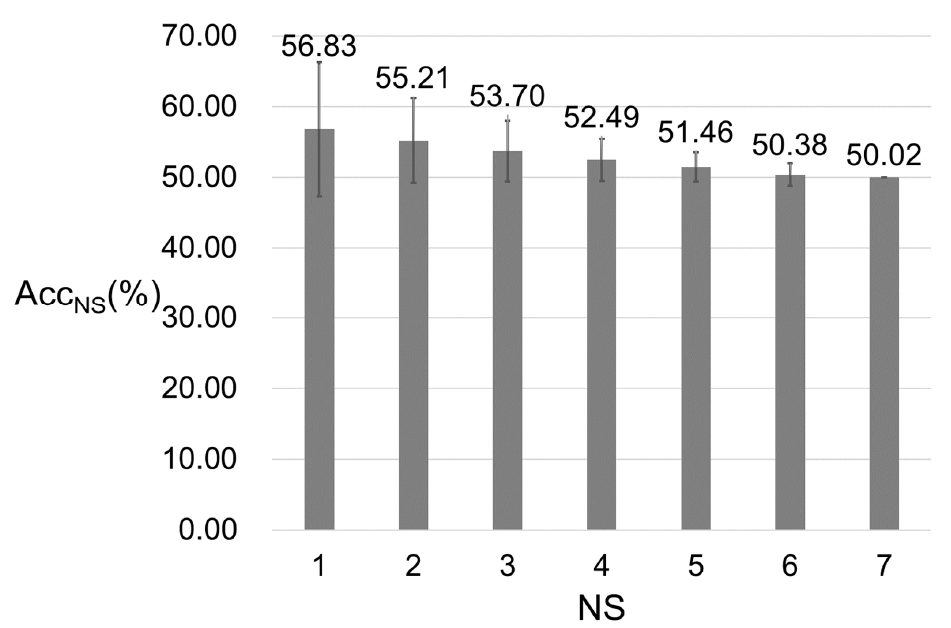
Figure 10. Relation between Acc NS-mean and NS. NS is the number of subjects. For each NS, we listed all possible subject combinations of NC subjects and constructed a new dataset for each combination by combining datasets of subjects in the combination. For each combination, after performing the random forest algorithm, we could get an accuracy. The highest one among the accuracies was marked as Acc NS . The figure shows the trend of Acc NS changed as the NC changed.